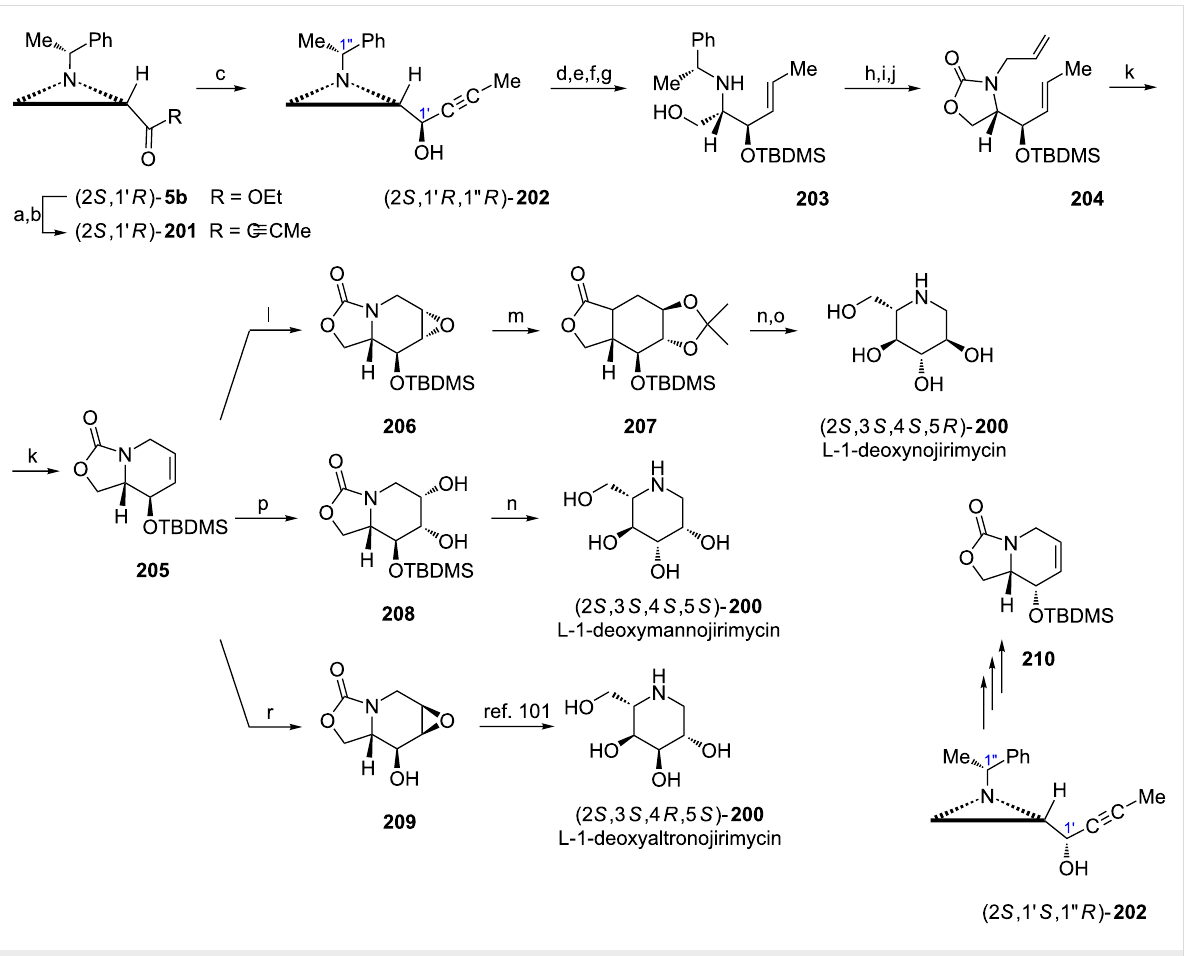
Scheme 53: Syntheses of ʟ -1-deoxynojirimycin ((2 S ,3 S ,4 S ,5 R )- 200 ), ʟ -1-deoxymannojirimycin ((2 S ,3 S ,4 S ,5 S )- 200 ) and ʟ -1-deoxyaltronojirimycin ((2 S ,3 S ,4 R ,5 S )- 200 ). Reagents and conditions: a) MeONHMe, iPrMgCl, THF, 0 °C, 1 h; b) MeC ≡ CMgBr, THF, − 78 °C, 1 h and rt, 1 h; c) NaBH 4